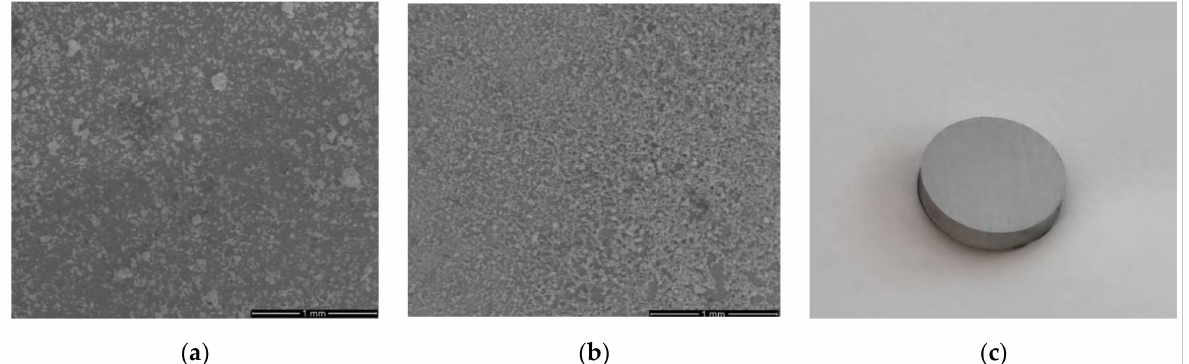
Figure 3. SEM images for the depositions with the following structures after corrosion tests: ( a ) MnTa 2 O 6 /5,15-(4-carboxy- phenyl)-10,20-bis-phenylporphyrin (optical microscopy); ( b ) 5,15-(4-carboxy-phenyl)-10,20-bis-phenylporphyrin/MnTa 2 O 6 (optical microscopy); ( c ) is the steel disk electrode (OL), 10 mm diameter and a thickness of 2 mm (macropicture obtained with a Nikon camera, Tokyo,